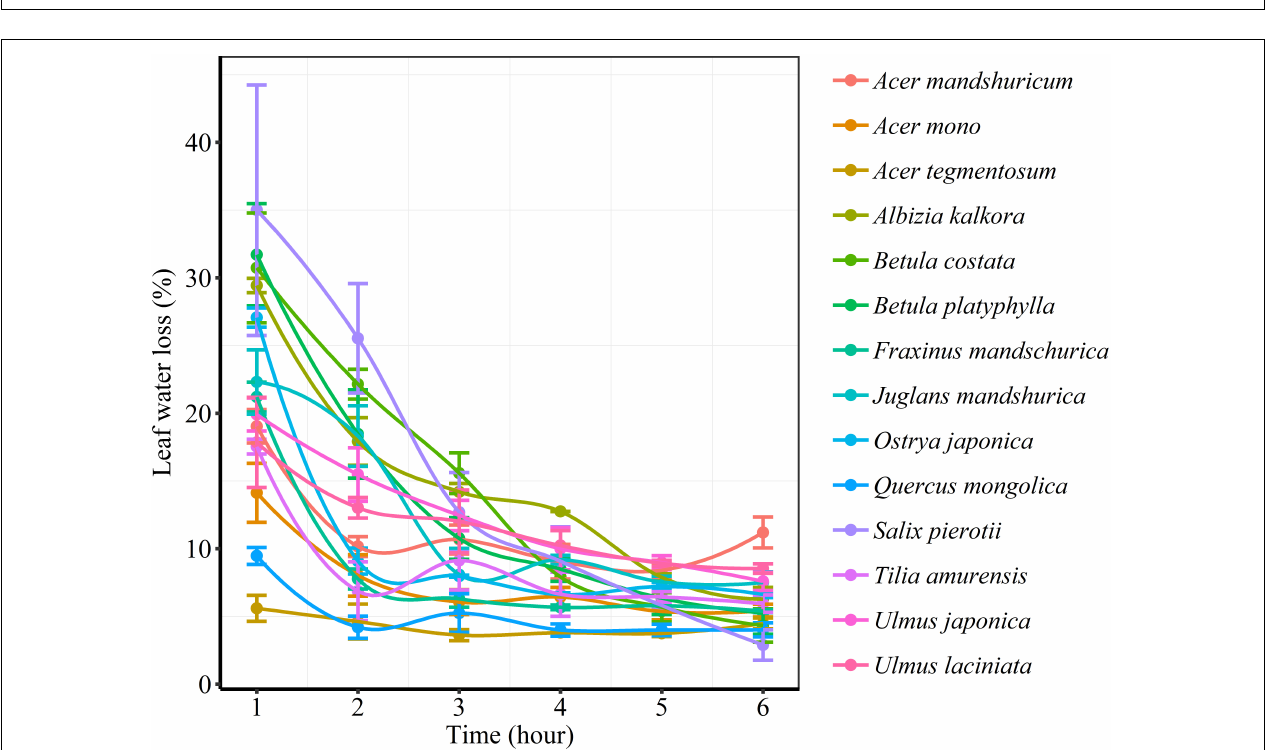
FIGURE 2 | Relationships of volume-based leafing intensity with individual leaf area (A) and individual leaf mass (B) from linear mixed models with leafing intensity as the mixed factor and tree species as the random factor. Marginal R 2 (cid:0) R 2 m (cid:1) reflects the proportion of the variance explained by fixed factors and conditional R 2 (cid:0) R 2 c (cid:1) reflects the proportion of the variance explained by both fixed and random factors. Average value per tree species and its 0.1-fold standard error were given. Gray bands show 95% confidence intervals. The abbreviations of tree species were provided in Table 1 .